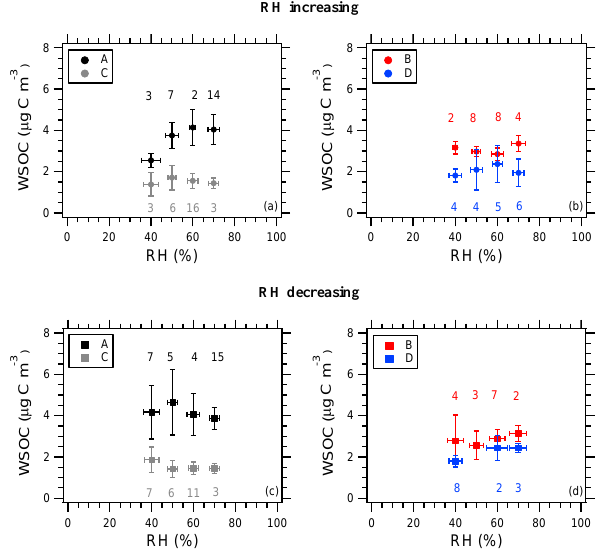
Figure 4. Hourly averaged WSOC as a function of RH for (a) Pe- riods A and C and (b) Periods B and D during the times of RH increasing and (c) Periods A and C and (d) Periods B and D dur- ing the times of RH decreasing at SPC. The WSOC was binned into 10%RH bands starting at 40%RH. The error bars represent the standard deviation at each bin. Numbers above or below points represent the number of data points in each